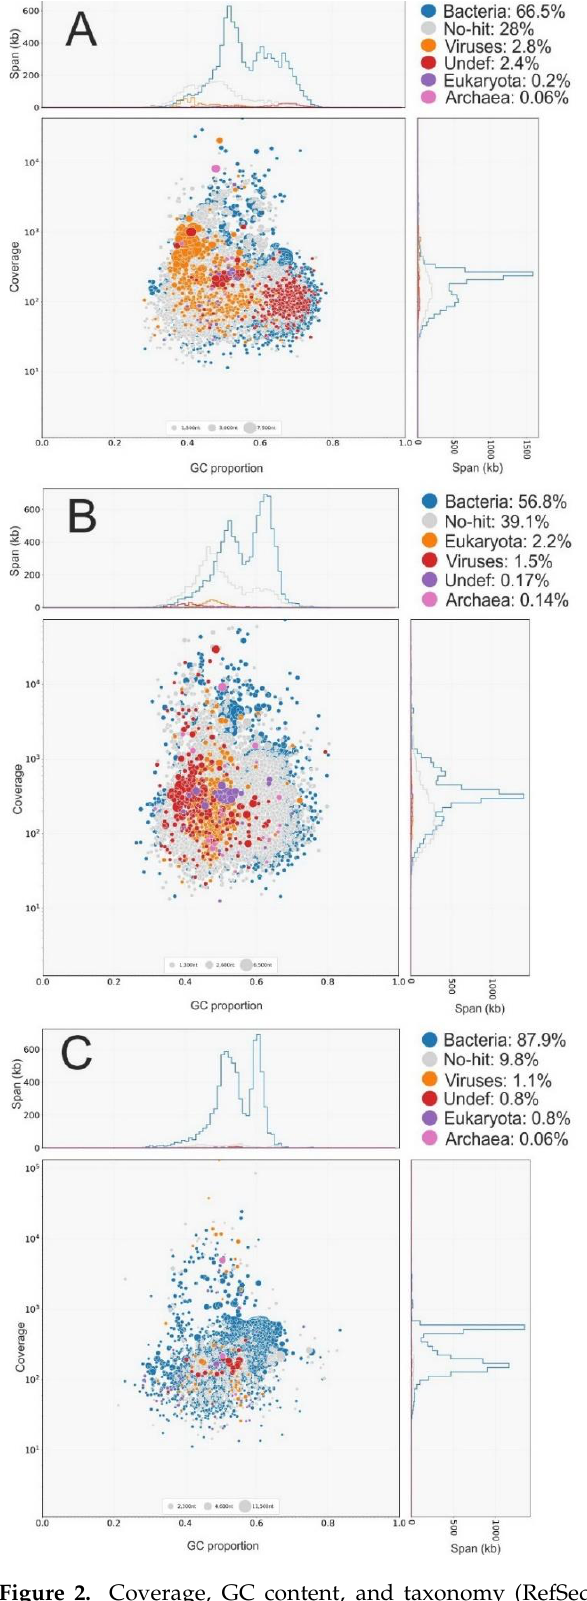
Figure 2. Coverage, GC content, and taxonomy (RefSeq) of contigs from metatranscriptomes. ( A ) — RVP1, ( B ) — RVP2, and ( C ) — RVP3.